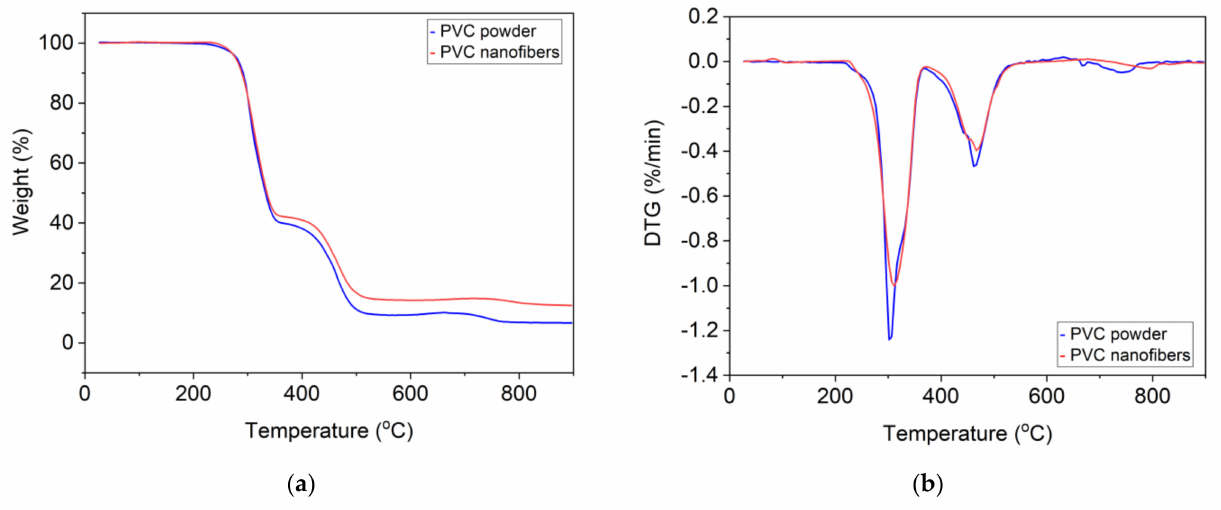
Figure 5. TGA and DTA curves of PVC powder and nanofibers: ( a ) TGA, ( b ) DTA